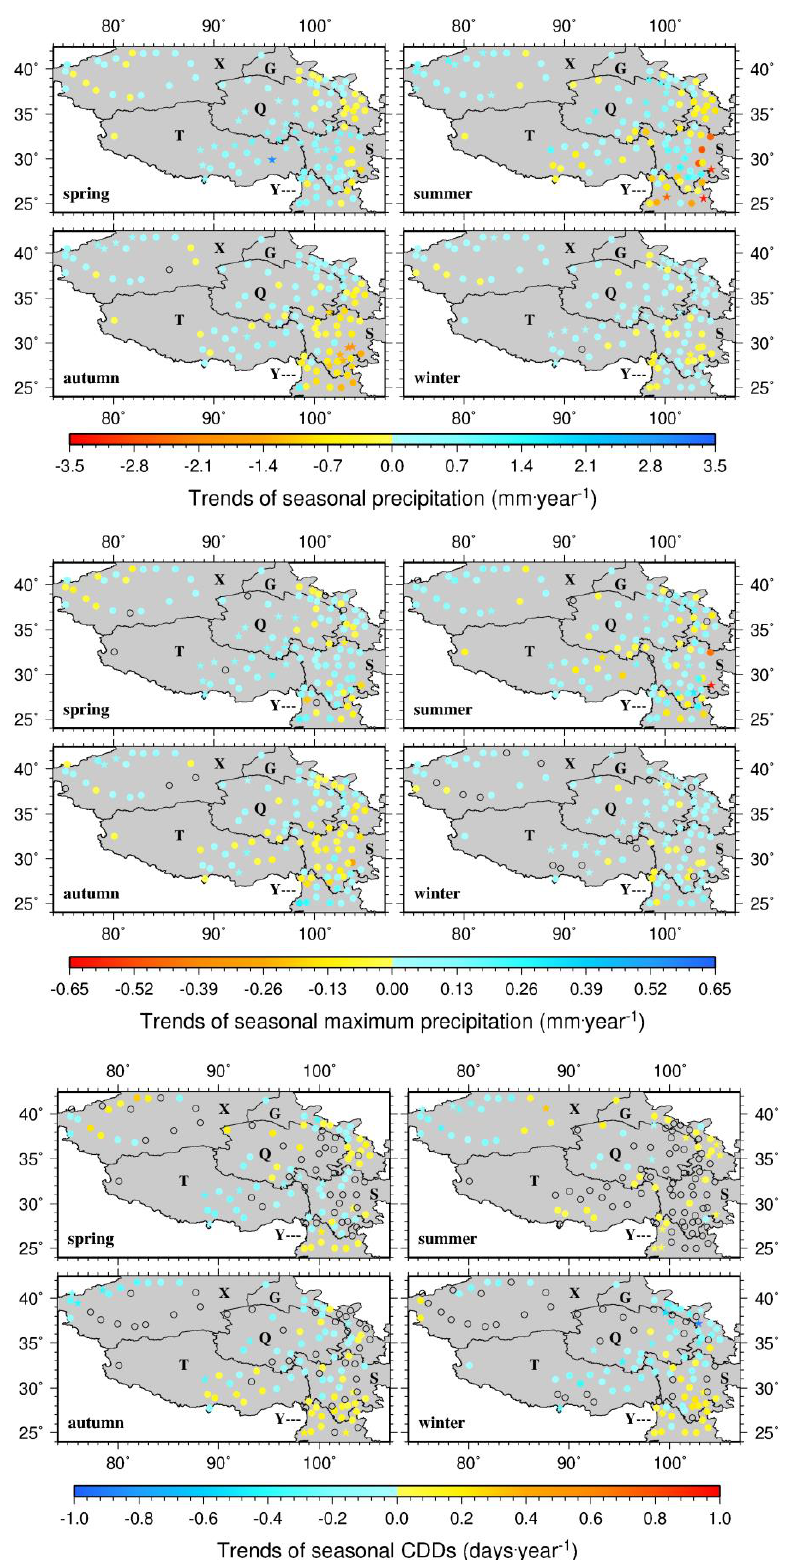
Figure 4. Spatial distributions of the trends of seasonal precipitation variables during 1963–2015. Stars represent statistically significant trends ( p < 0.05). Open circles represent no trends.